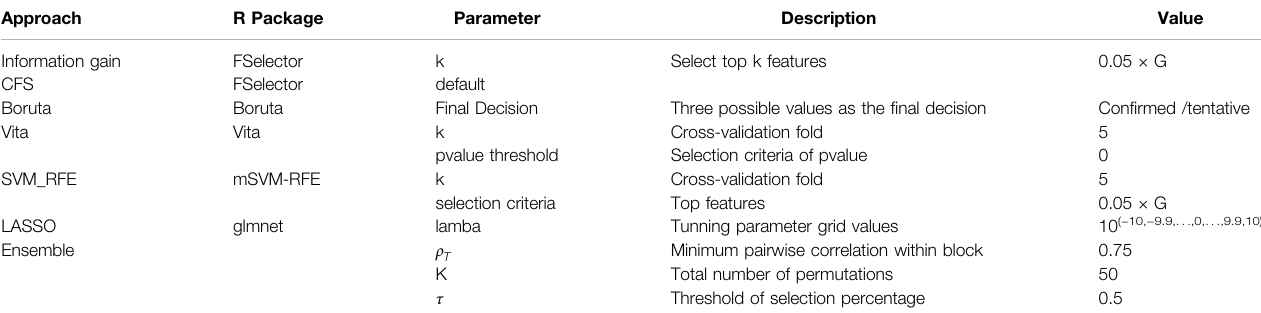
TABLE 3 | Parameters used for feature selection methods.